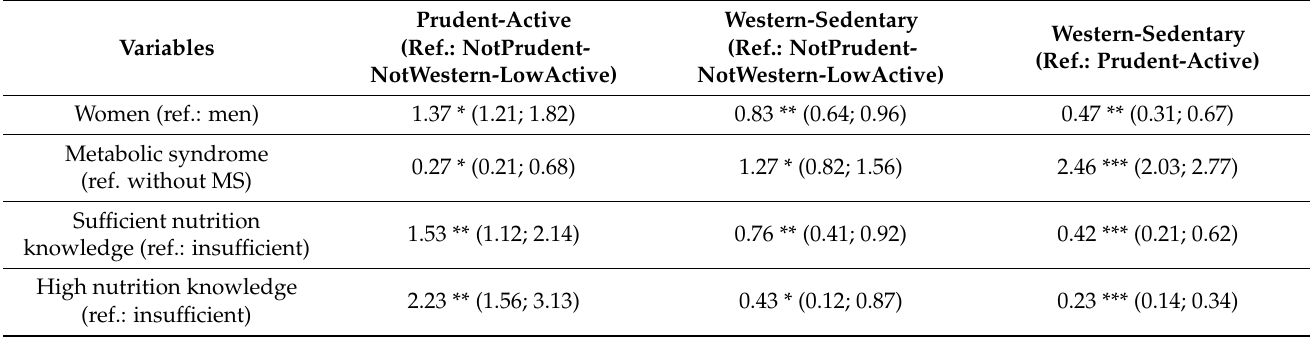
Table 4. Odds ratio (95% confidence interval) for dietary-lifestyle patterns by demographic factors, metabolic syndrome occurrence and nutrition